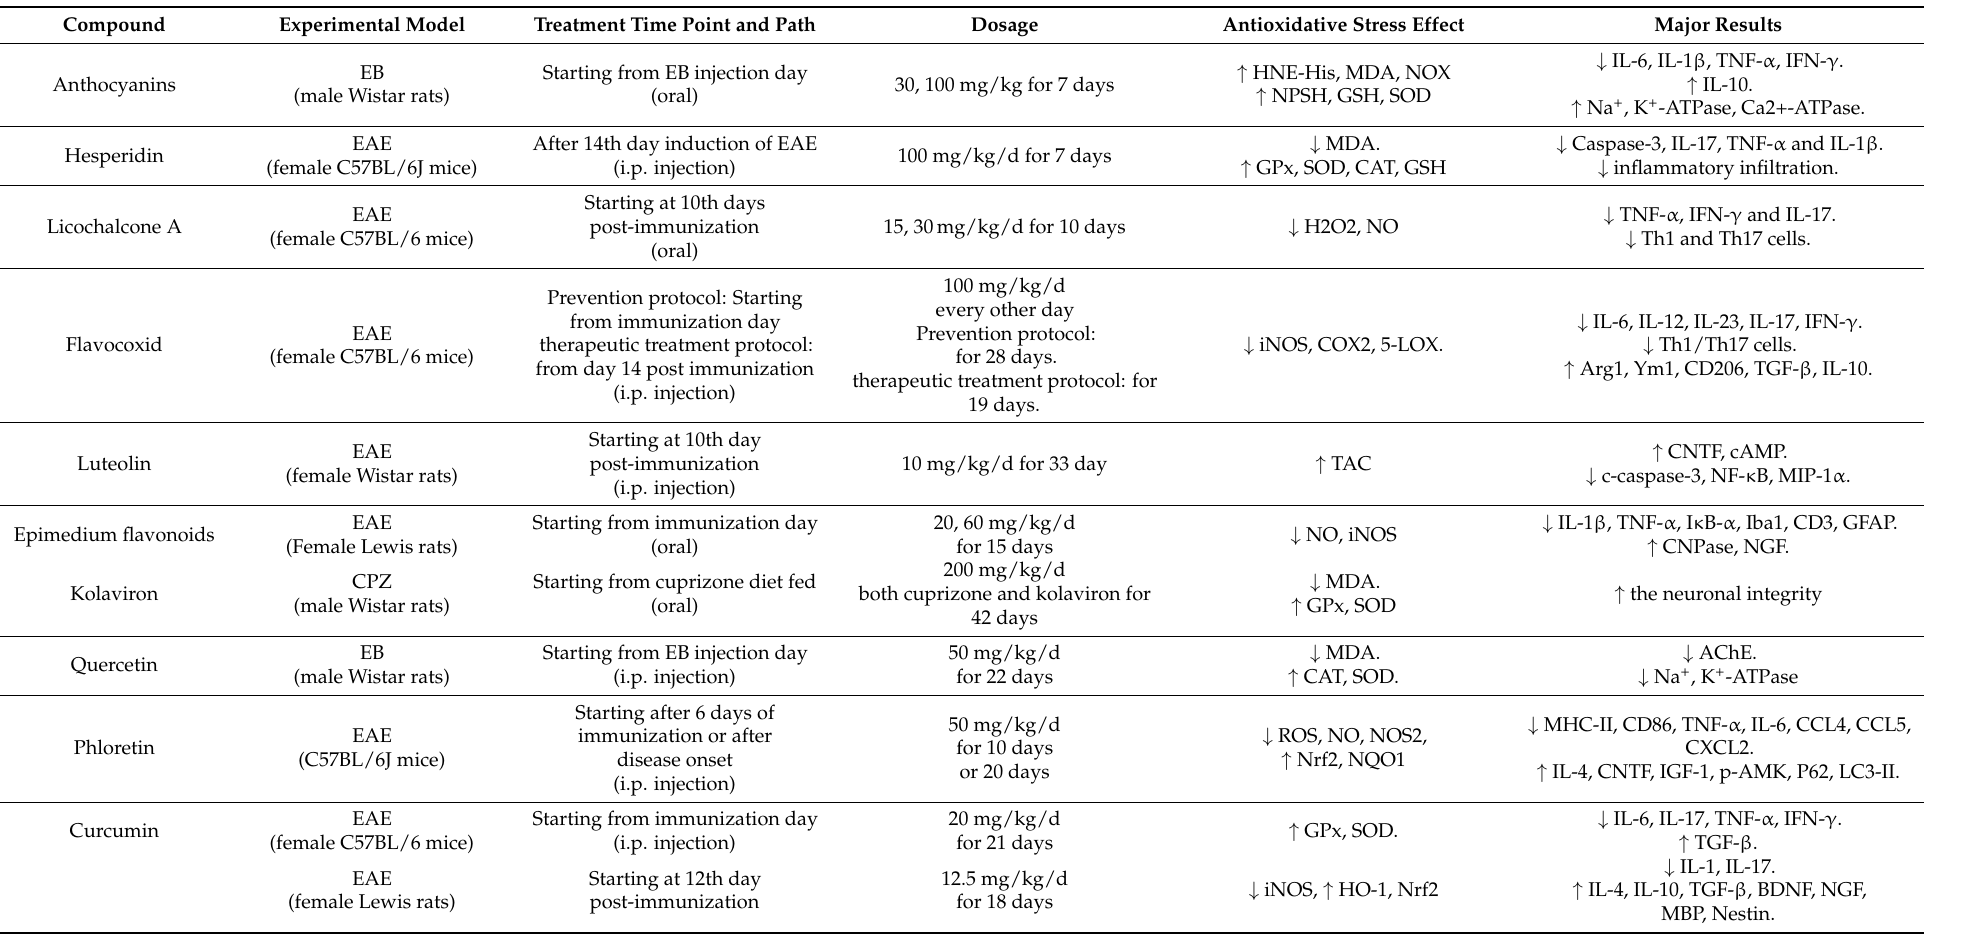
Table 1. The anti-oxidative stress properties of natural products used in animal models of